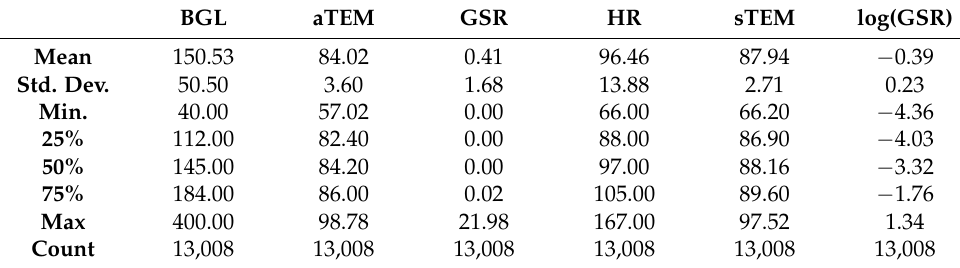
Table 2. Statistical analysis of Subject 563 from the OhioT1DM